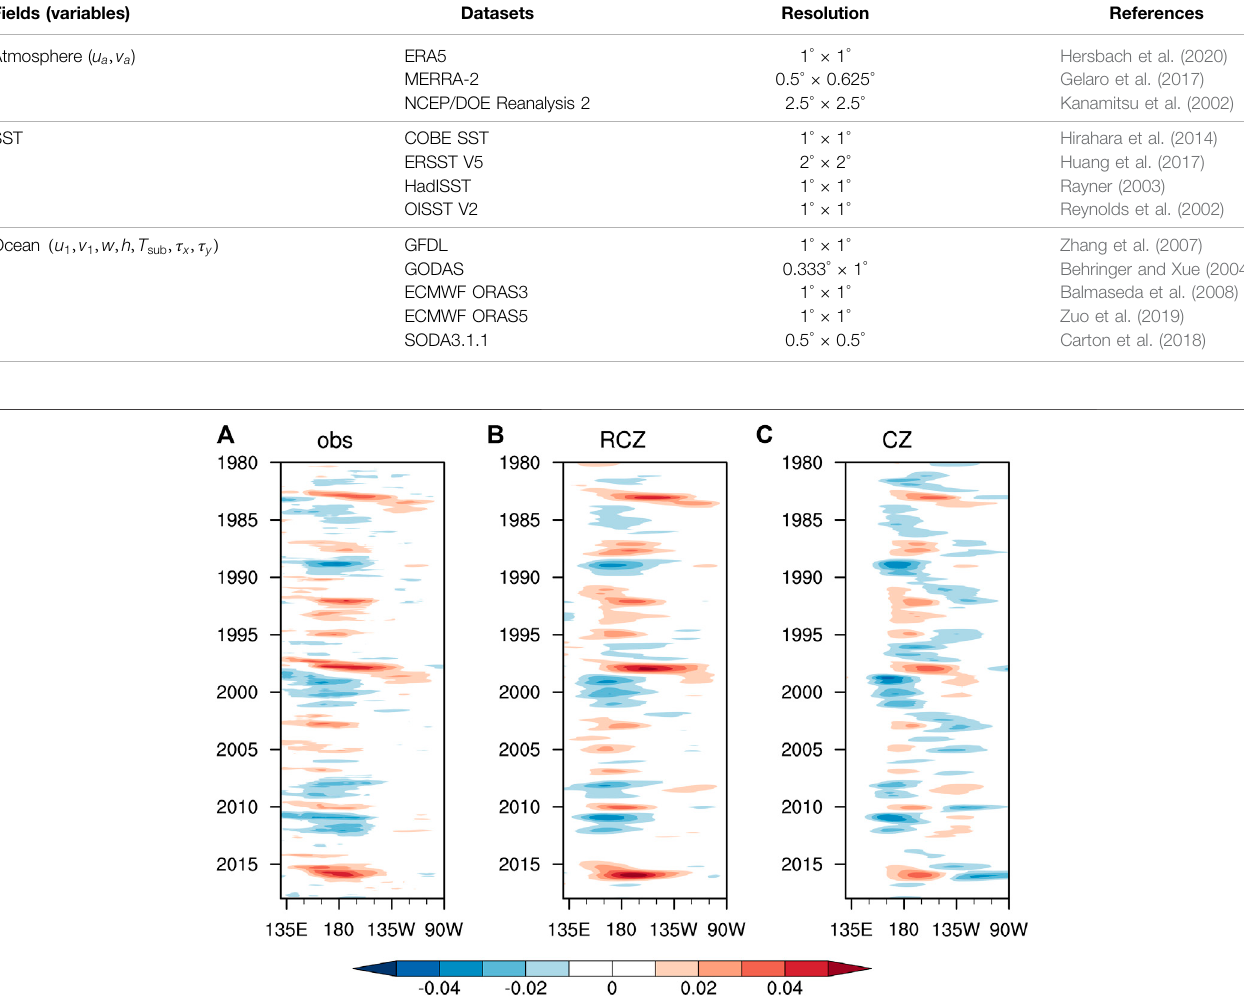
( Figure 5 ). In comparison, the CZ model simulation exhibits less correlation with the observation and a larger root mean square error. As indicated by the composite analysis shown in Figure 6 , the spatial pattern and the magnitude of zonal wind stress anomalies during the mature phase (i.e., November to January) of the two types of El Niño and La Niña are well captured by RCZ. In contrast, the CZ model-simulated equatorial (off-equatorial) zonal wind stress anomalies to the west (east) of SSTA maximum are signi fi cantly weaker (stronger) than observed.